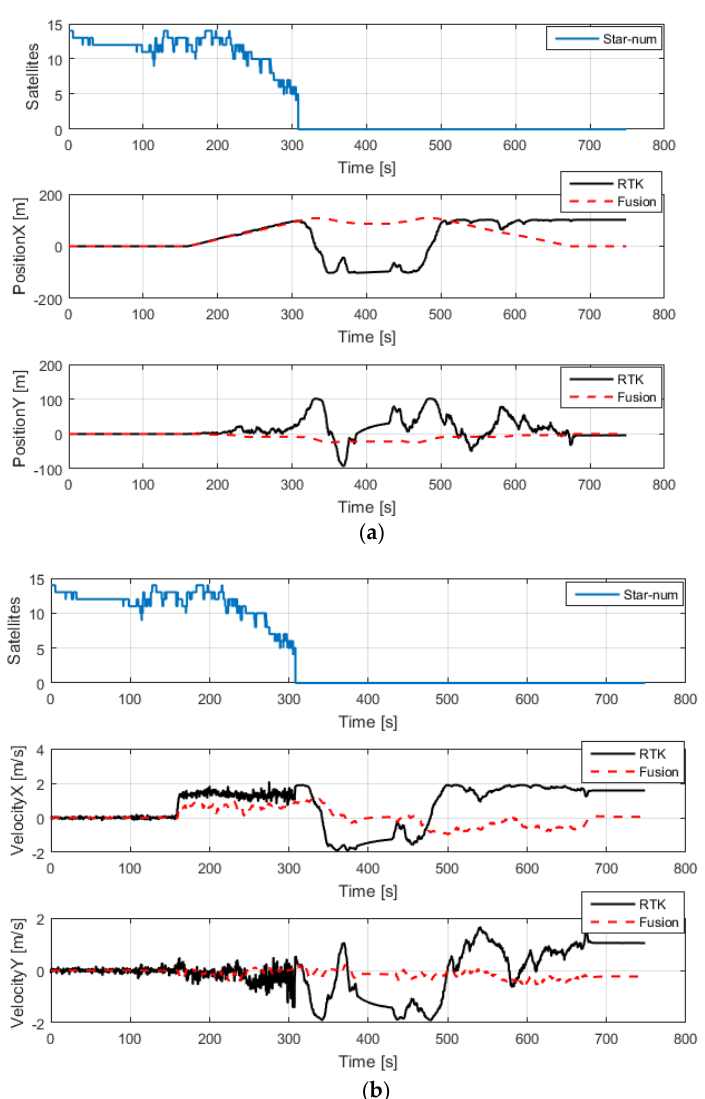
Figure 5. Comparison of the state estimation of the RTK system and the fusion-based system in an indoor-to-outdoor transition area. ( a ) The number of satellites and the comparison curve for position; ( b ) the number of satellites and the comparison curve for velocity. The blue solid line represents the number of satellites, the red solid line represents the fusion data, and the black solid line represents the ground truth, which was provided by the RTK system.